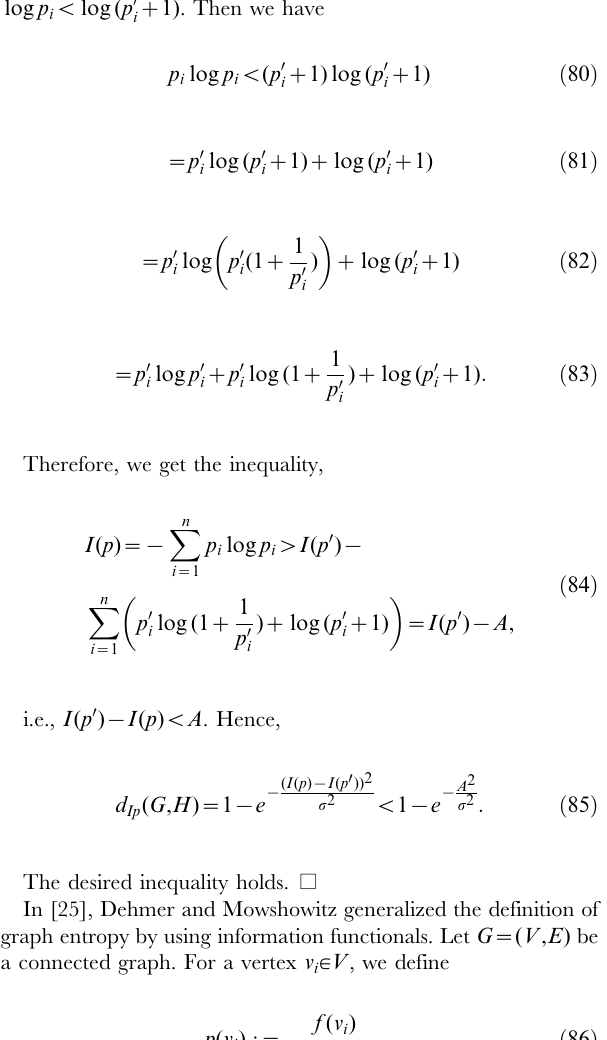
Figure 1. All the values of d W ( T , T 0 ) (blue) and d R ( T , T 0 ) (red). The Y-axis denotes the values of the distance measure and the X-axis denotes the graph pairs. doi:10.1371/journal.pone.0094985.g001 PLOS ONE |